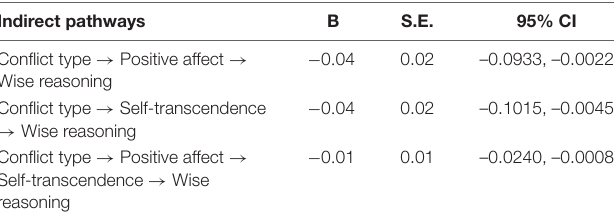
TABLE 3 | Indirect pathways from conflict type to wise